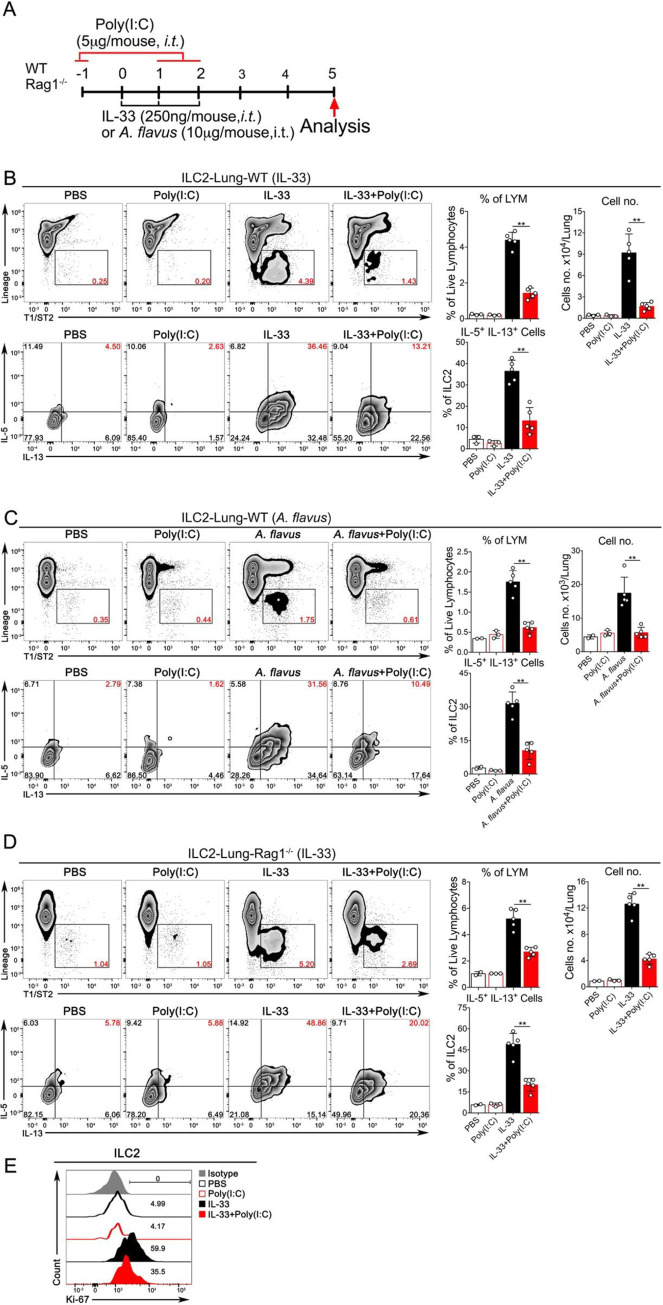
Poly(I:C) inhibits the activation and proliferation of ILC2 cells induced by IL-33 or A. flavus in WT and Rag1-/- mice.A. Experimental protocol showing the animal groups (WT and Rag1-/-), the corresponding treatment regimen and timeline. B. C57B6/J WT mice were treated with PBS, Poly(I:C), IL-33 or IL-33+Poly(I:C). Lung single cell suspensions were prepared and the percentage and number of ILC2 cells in lungs were analyzed. In addition, lung cells were stimulated with PMA in cultures as described in the Materials and Methods. The percentage of IL5+/IL13+-double positive ILC2 cells in lungs were analyzed. (n = 3–5 per group as indicated with open circles). C. Similar to B, instead of IL-33, A. flavus was used. (n = 2–5). D. Similar to B, instead of WT mice, the Rag1-/- mice were used. (n = 2–5 per group as indicated with open circles). E. C57B6/J WT mice were treated with PBS, Poly(I:C), IL-33 or IL-33+Poly(I:C). The lung ILC2 cells were analyzed with Ki-67 staining and isotype antibody. The result is a representative of three independent experiments.